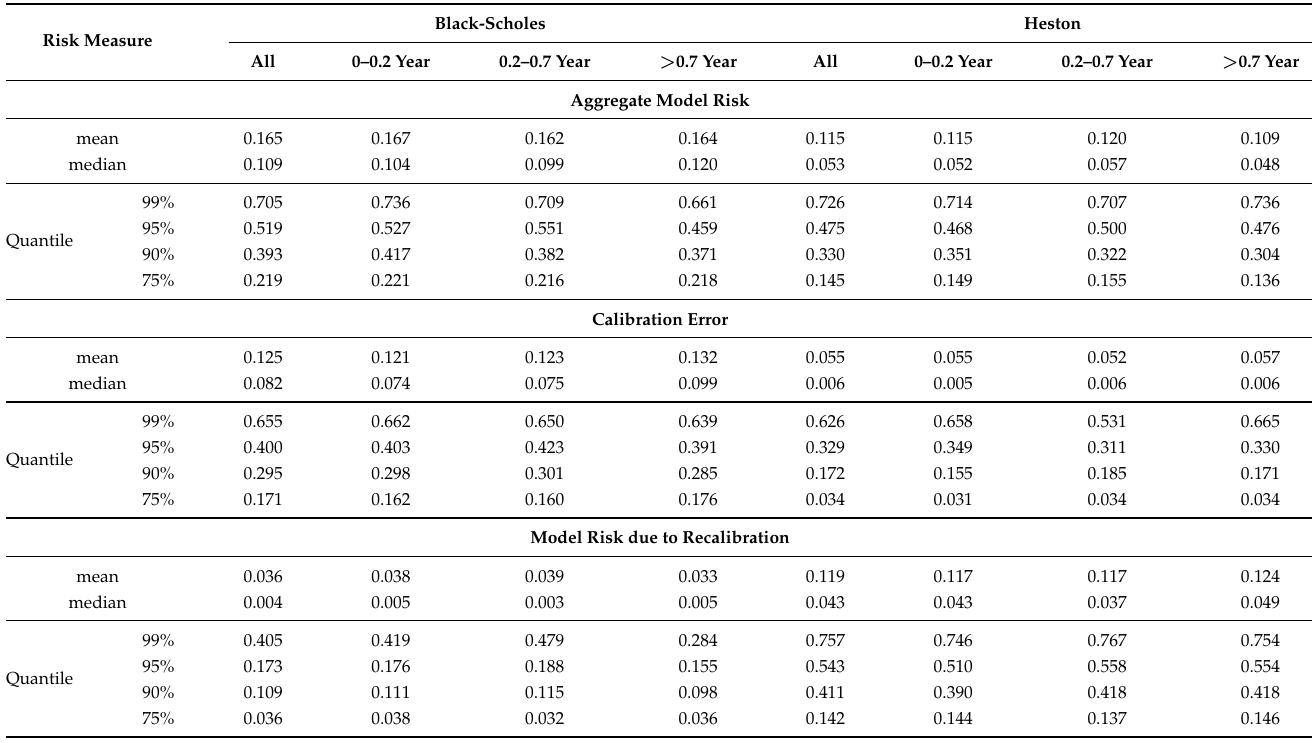
Table 4. Model risks (in terms of relative entropy) under different models, by maturity buckets, for GOOG (daily recalibration